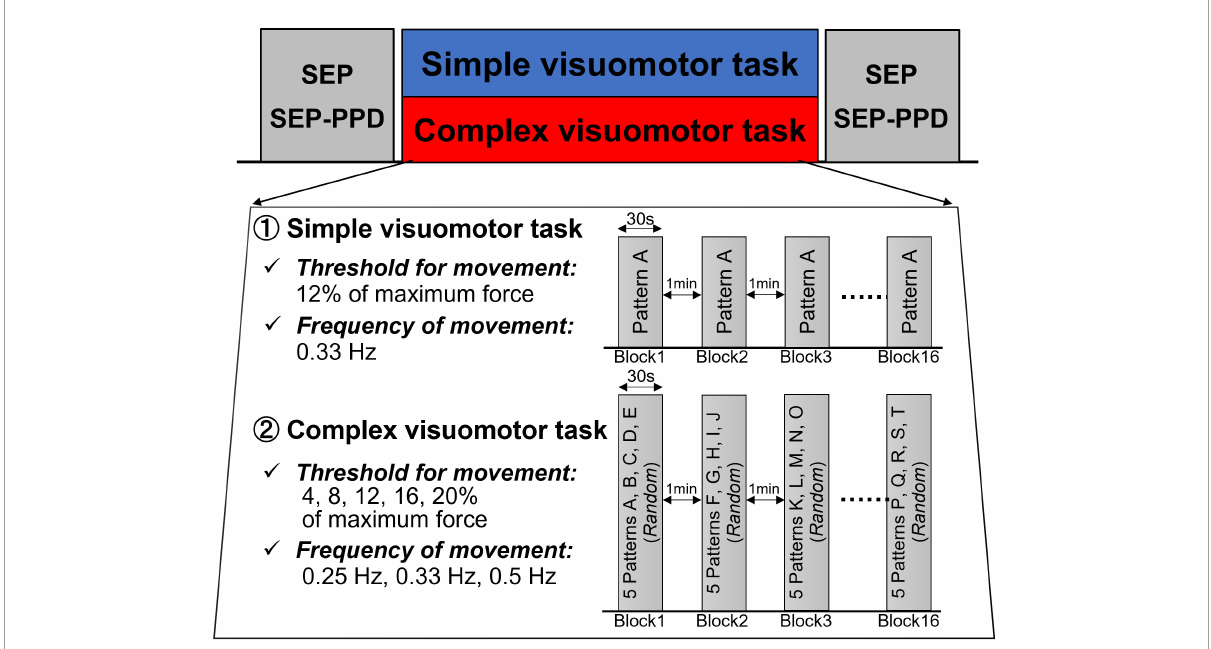
FIGURE2 Experimental procedure. First, we measured SEP and SEP-PPD as baseline values. The SEP and SEP-PPDP were then measured again after the intervention of either the simple or complex visuomotor task. In the simple visuomotor task, the subjects performed only one task pattern with a constant frequency and force. In the complex visuomotor task, the target was set to move through 5 randomly selected movement patterns 10 times in a random order over 30 s. Each subject performed a total of 16 trials (from Block1 to Block16), 30 s/block, separated by 1-min